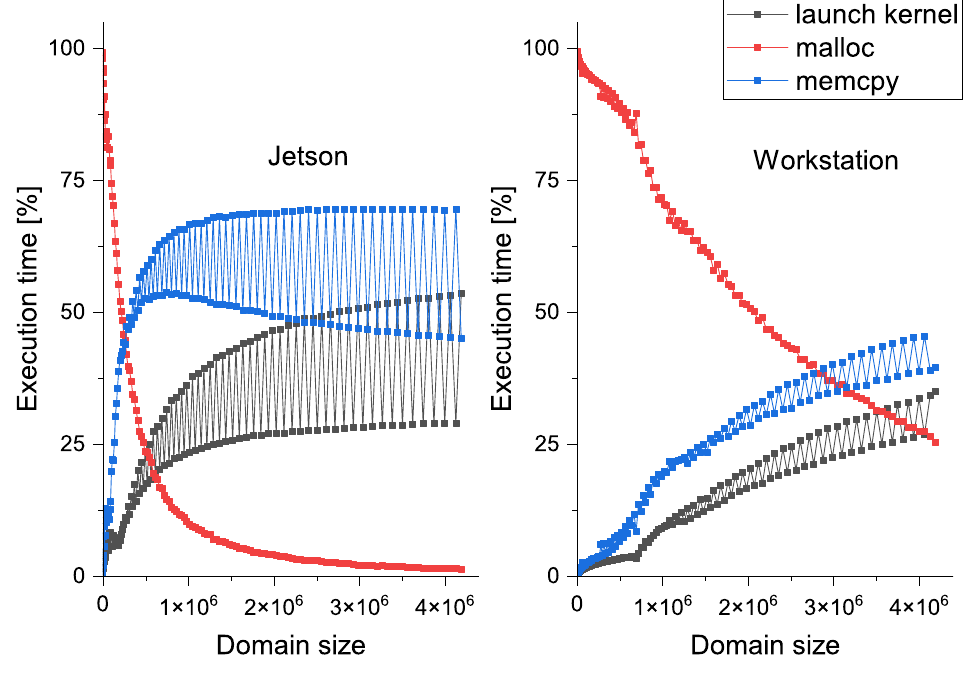
Figure 9. Relative execution time of CUDA API